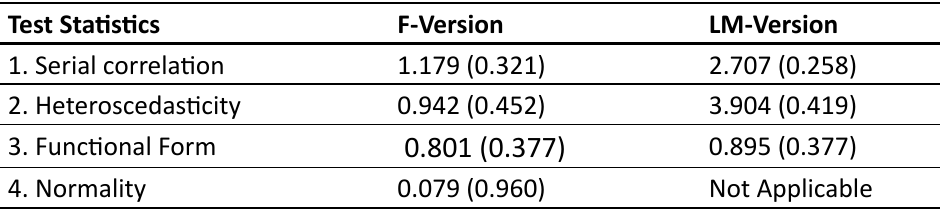
Table 7: Reliability Tests